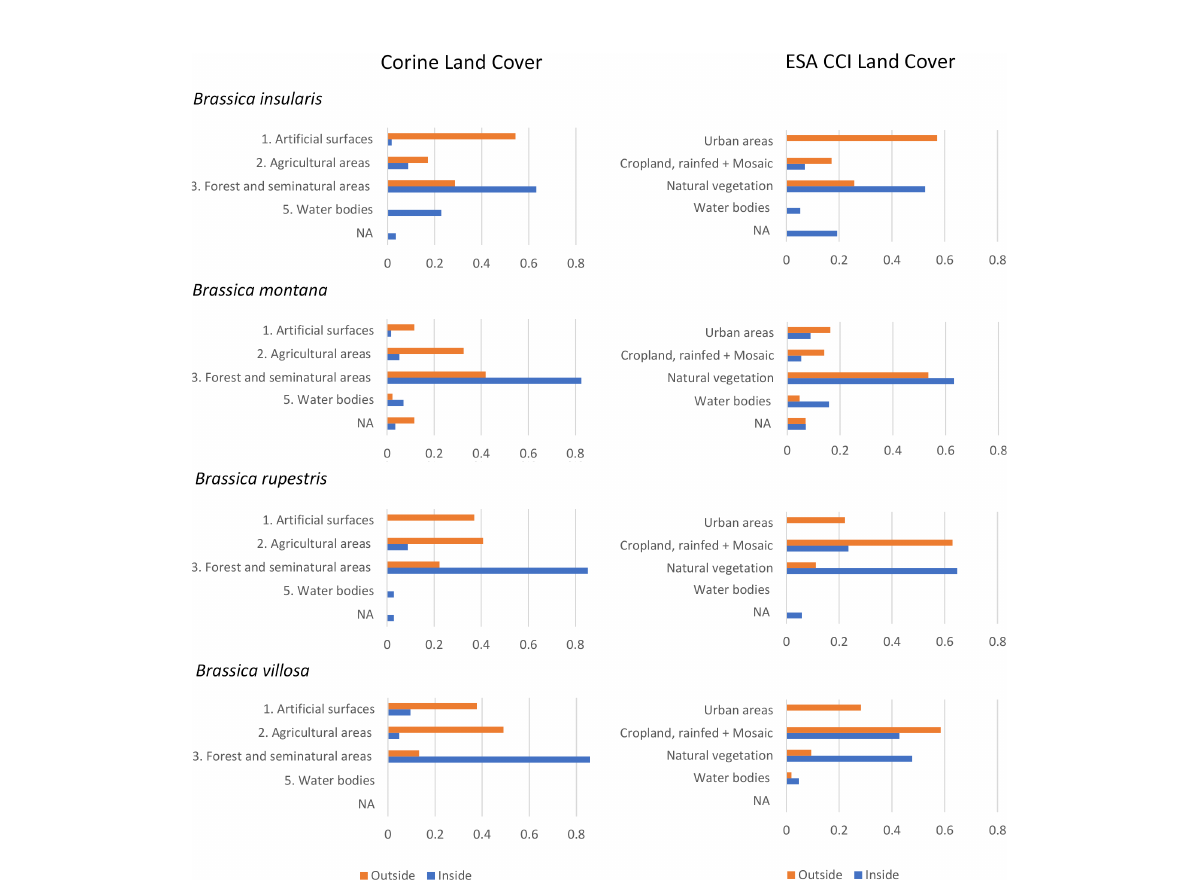
FIGURE 4 LCLU of site holding priority Brassica CWR populations located outside (orange) and inside (blue) Natura 2000 network according to Corine (left) and ESCA CCI (right) classi fi